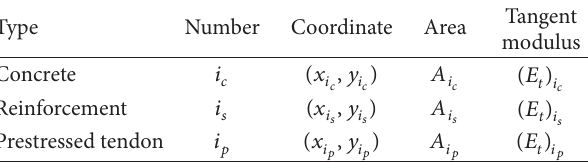
Table 1: Characteristics of section fiber.